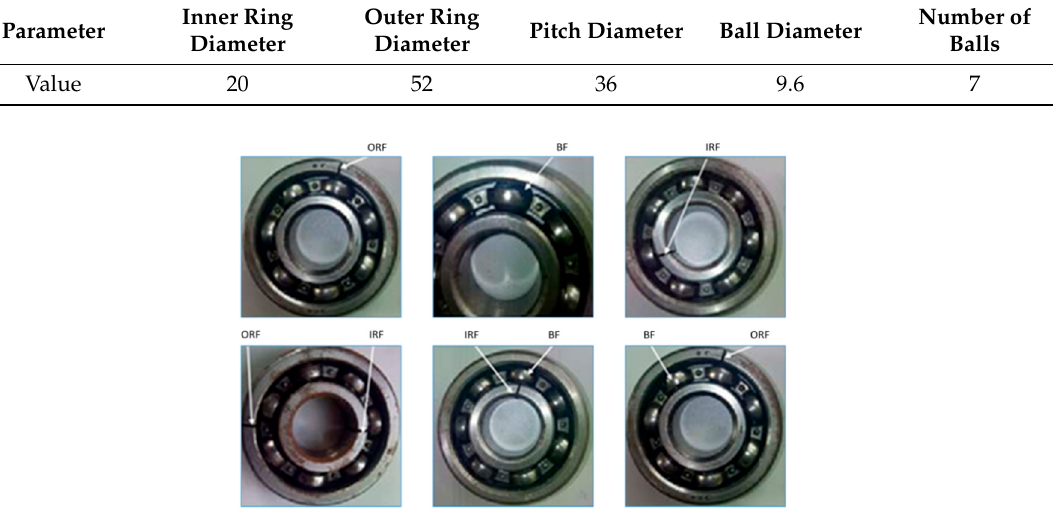
Figure 22. Bearing single point fault and compound fault. Table 7. Samples of the bearing in Experiment 2.